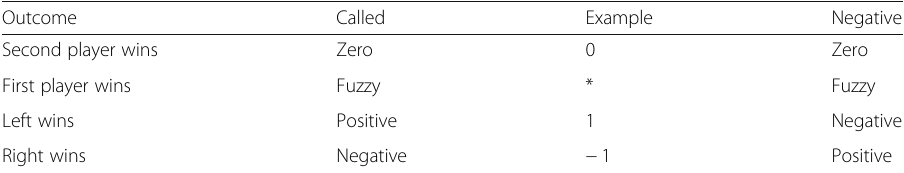
Table 1 Classification of the games by outcome Outcome